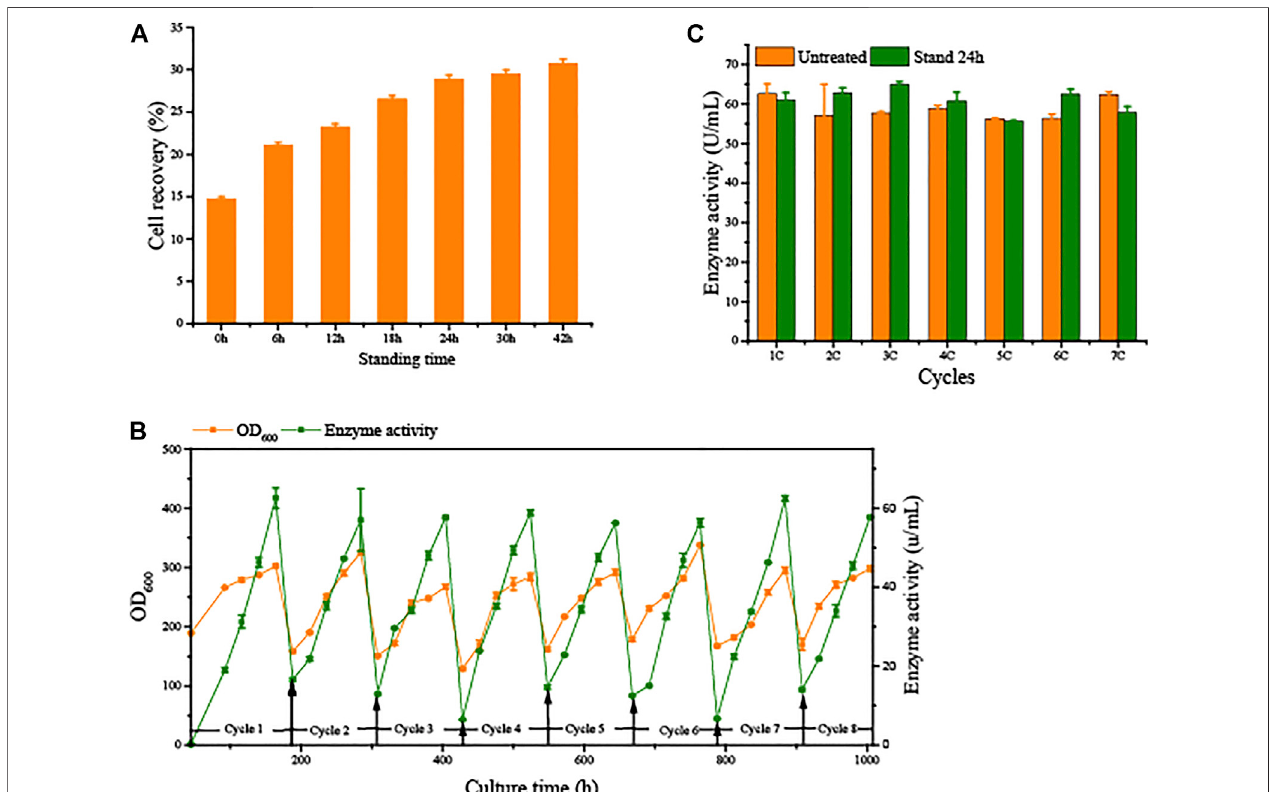
FIGURE4| Natural sedimentation torecyclecells forsemi-continuous cultivation. (A) Cellrecovery ofG/Pelat different sedimentation times. (B) Growth curve and enzyme activity curve of semi-continuous cultivation of G/Pel for natural sedimentation for 24 h to recycle cells. (C) Comparison between the untreated group and after sedimentation to recycle